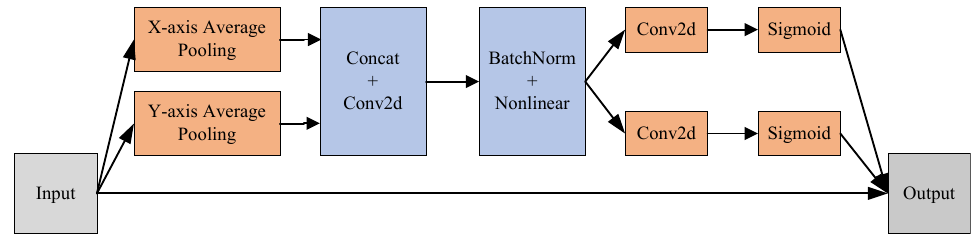
Figure 3. Coordinate attention